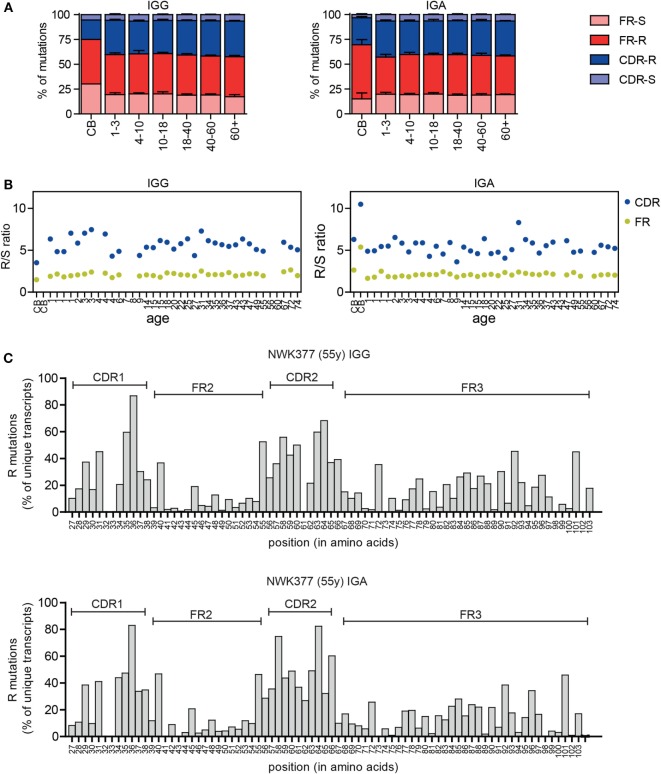
Replacement and silent mutations in IGG and IGA transcripts. (A) The percentage of replacement (R) and silent (S) mutations in the FR and CDR regions is stable between different age groups except for the cord blood (CB) samples. Means and SDs of the age groups are plotted. (B) The R/S ratio in the CDR and FR regions in HD does not correlate with age. (C) The frequency of R mutations at different amino acid locations is increased in the CDR regions in IGG and IGA transcripts. A representative sample is shown.